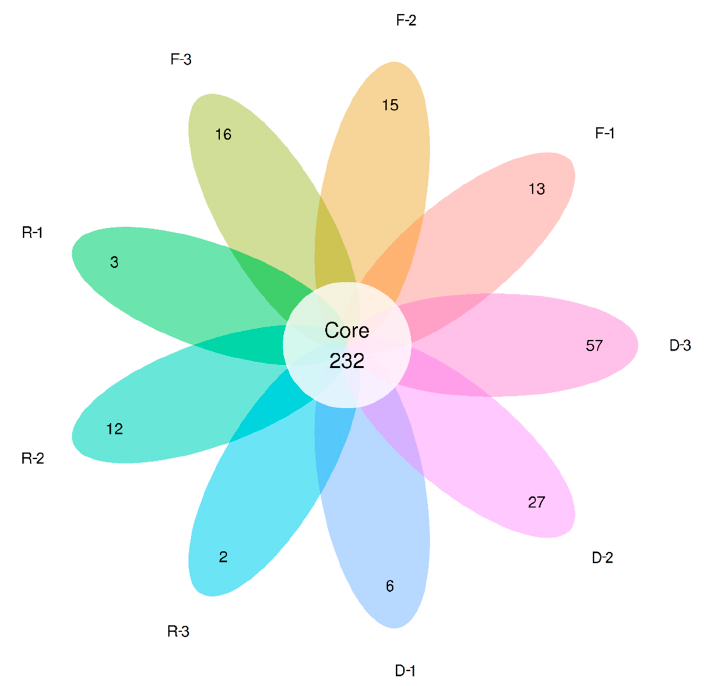
Figure 4. Venn diagram showing the number of unique and shared operational taxonomic units (OTUs) among biofilms in forested (F), restored (R) and degraded (D) rivers within the Anji City Region, PRC.